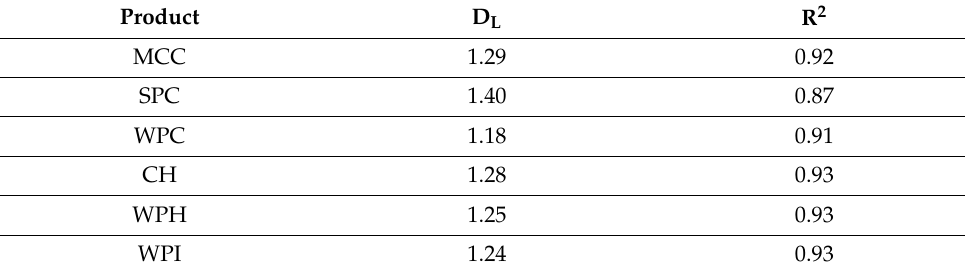
Table 5. Fractal dimensions and determination coefficients for high-protein milk powders.